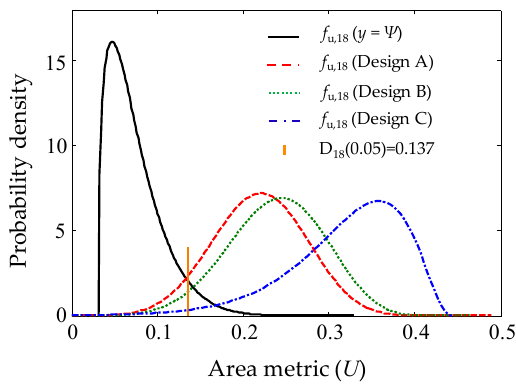
Figure 8. PDF of each area metric ( U ) for the three design conditions. Table 3. Statistical information of the f u,18 for the three experimental designs.